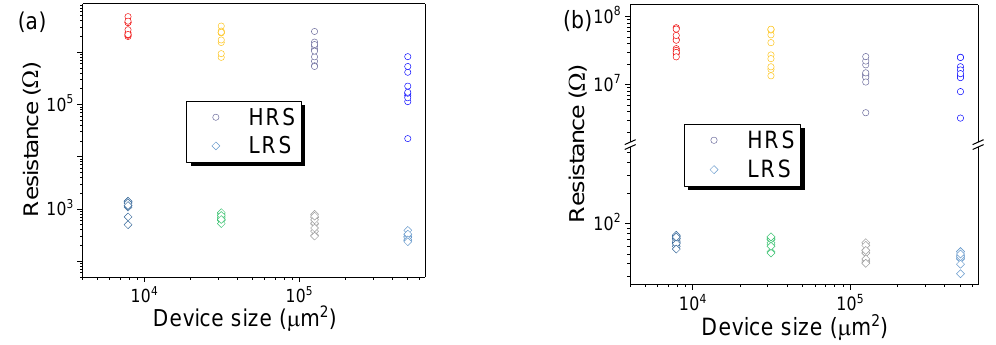
Figure 7. Device size dependence of the resistance for LRS and HRS for ( a ) the Co–Al LDH memristor and ( b ) the Co–Al LDH-adsorbed hexazinone